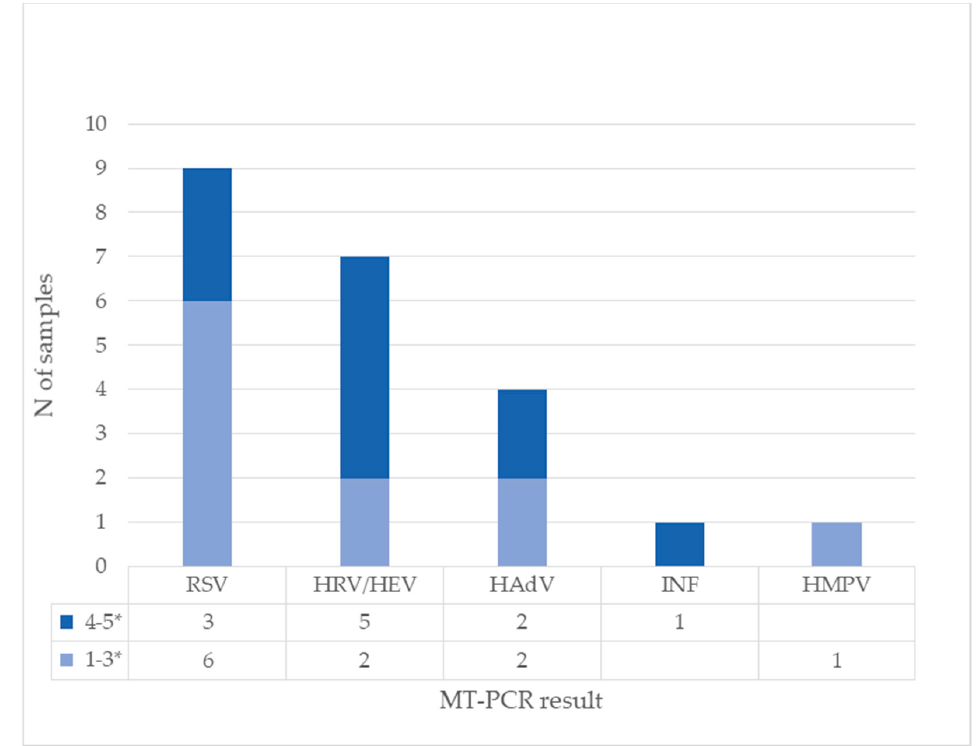
Figure 4. Detection of other viruses on MT-PCR in samples with high concentration of HBoV on quantitative PCR ( N = 28). Results of MT-PCR are expressed by 5-star representation marked as intensity (1-3* and 4-5*) In some samples, more than one other virus is present.